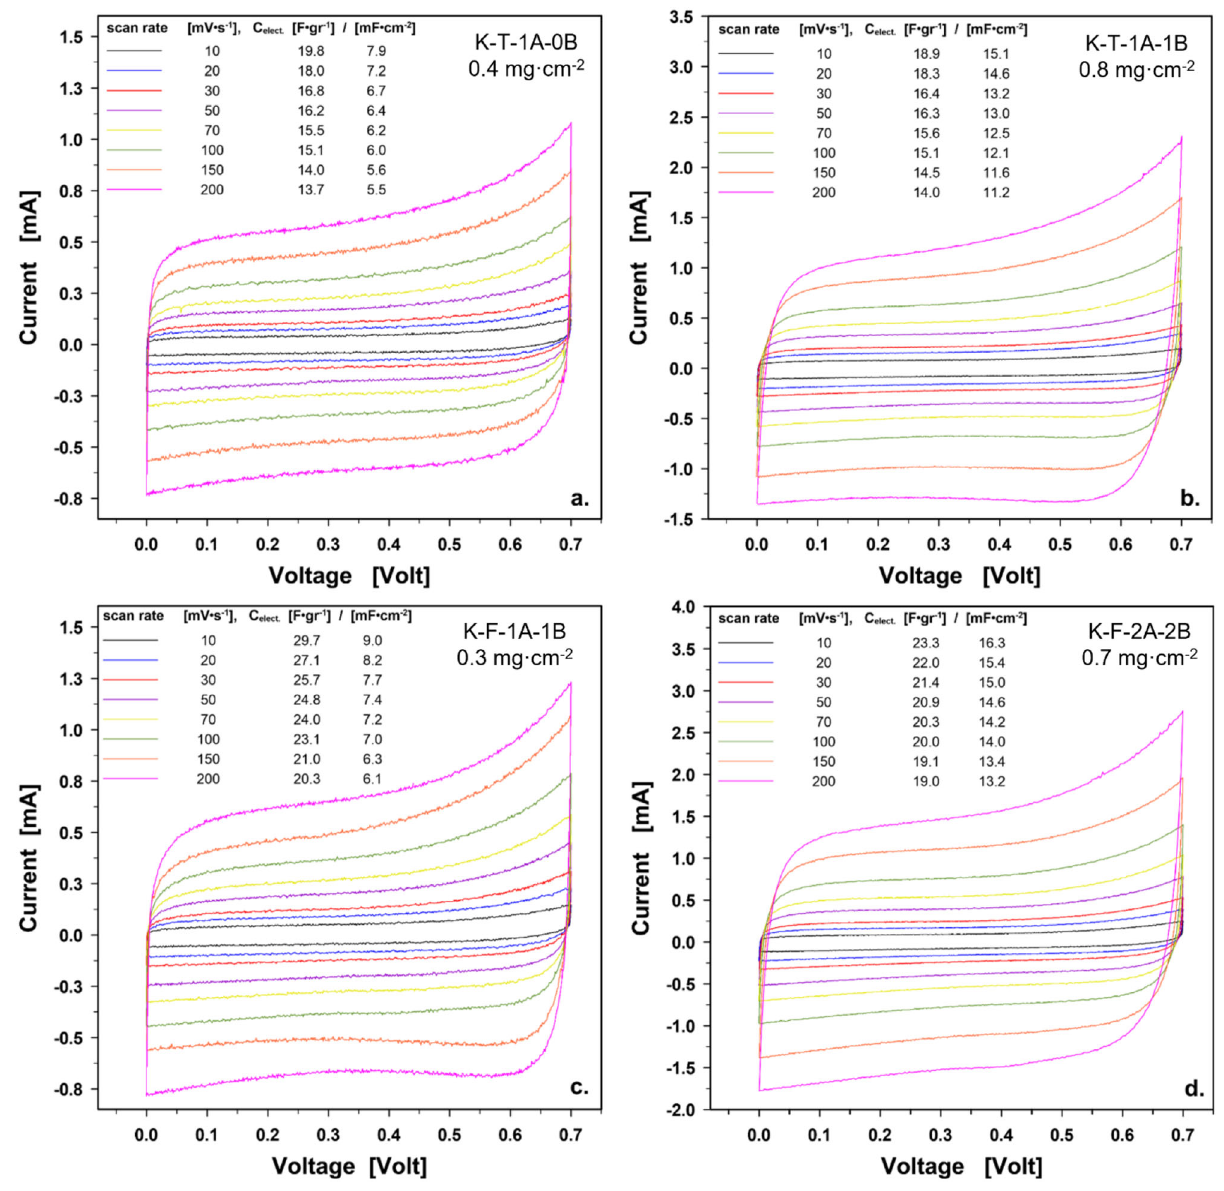
Fig. 7 Performance of supercapacitors. CV curves at different scan rates for the supercapacitors prepared by four different electrodes of variable loading. Neat graphene fl akes electrodes: a K-T-1A-0B, b K-T-1A-1B. Graphene/SiO x electrodes: c K-F-1A-1B, d K-F-2A-2B. See text for sample